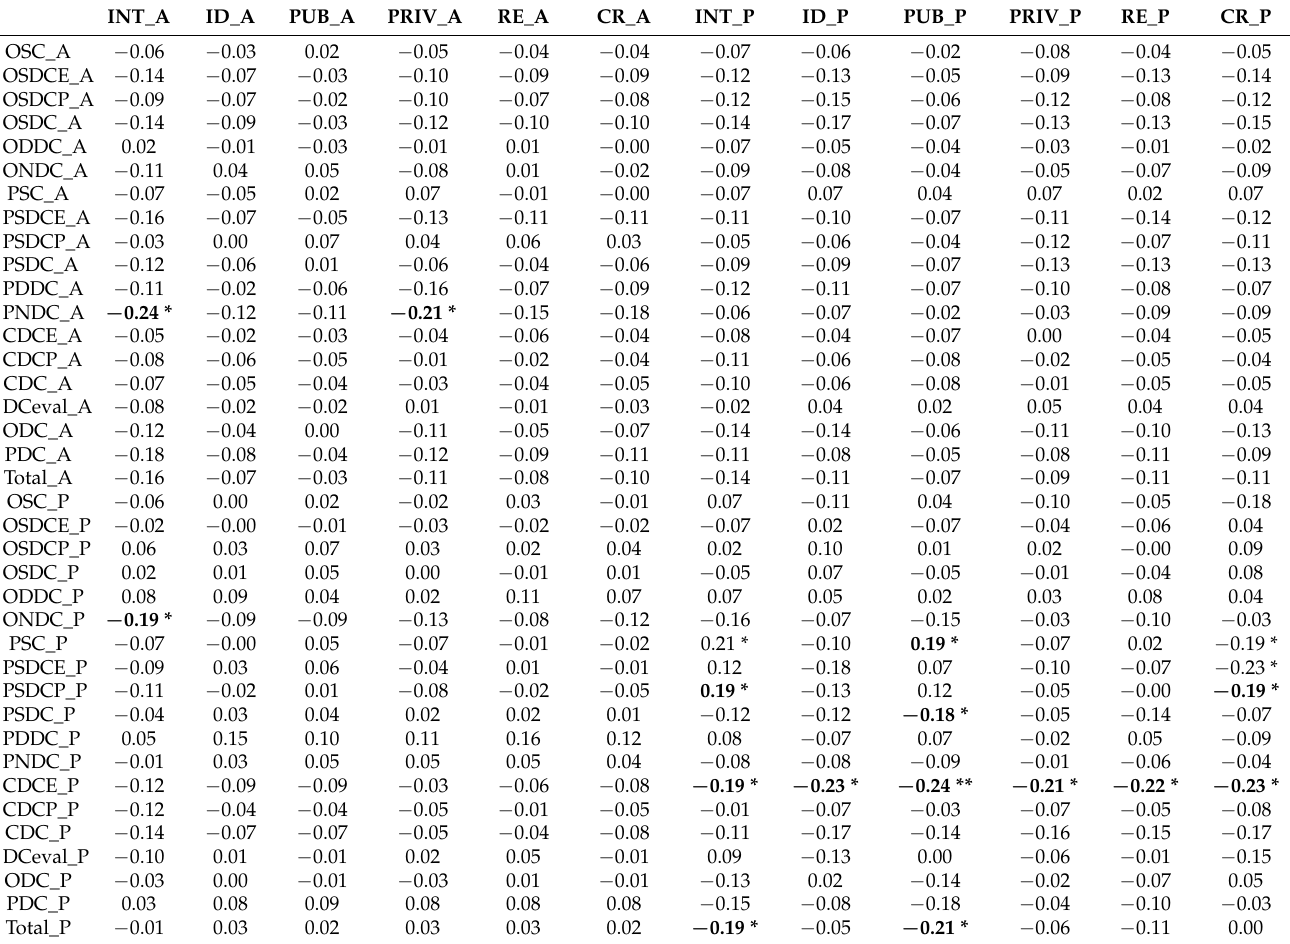
Table 3. Intercorrelations among path model variables for women (_A) and men